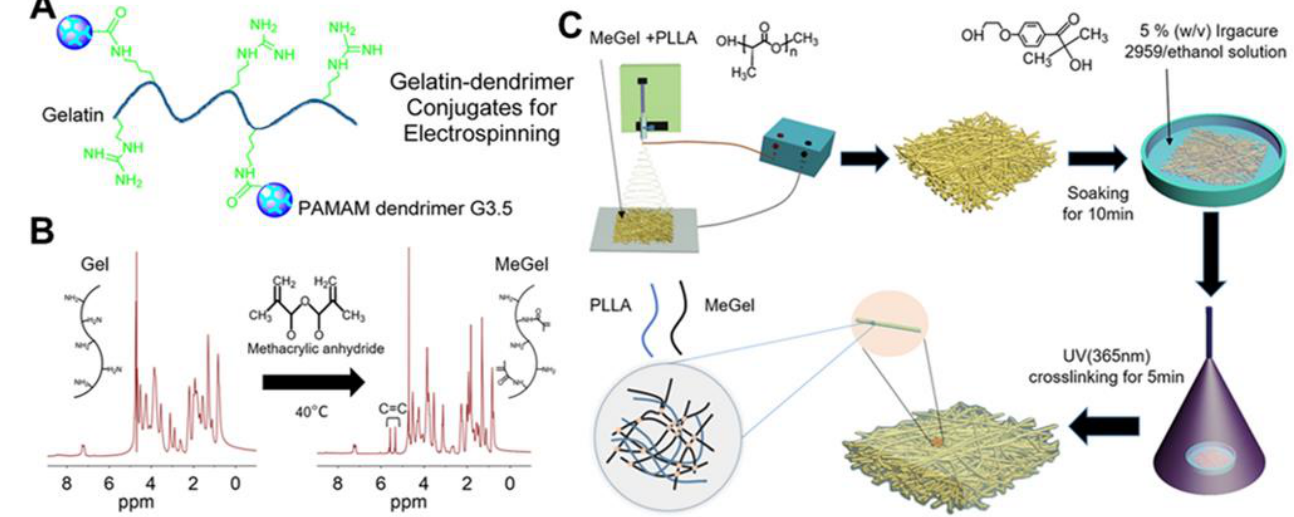
Figure 4. ( A ) Schematic illustration of the design of gelatin-PAMAM dendrimer G3.5 conjugates. ( B ) 1 H-NMR of gelatin (Gel) and MeGel. The MeGel was synthesized by the methacryloyl substitu- tion of Gel. ( C ) Schematic illustration of the construction of crosslinked MeGel/PLLA electrospun nanofiber mats by combining blend electrospinning with subsequent UV crosslinking process. ( A ) Reprinted with permission from ref [122], ACS Publications, 2013. ( B , C ) Reprinted with permission from ref [76], MDPI, 2022.